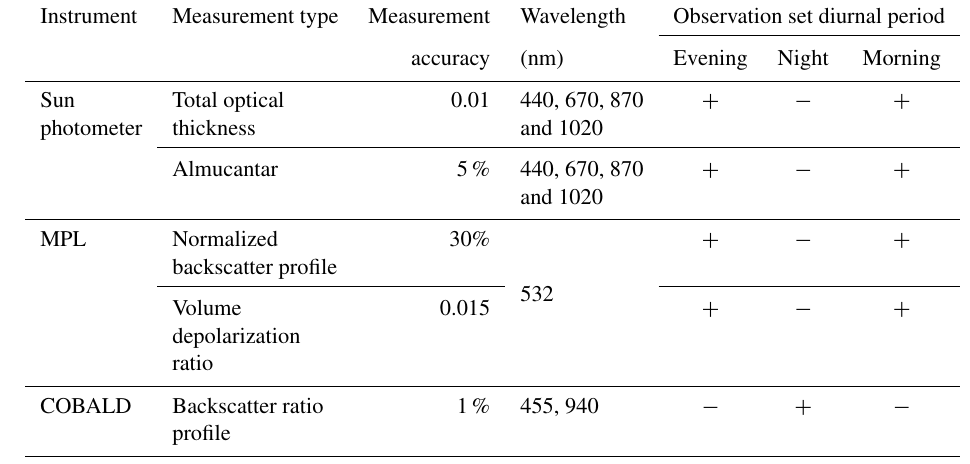
Table 2. Summary of the data and their combinations used by the GRASP multi-temporal retrieval scheme during KAUST